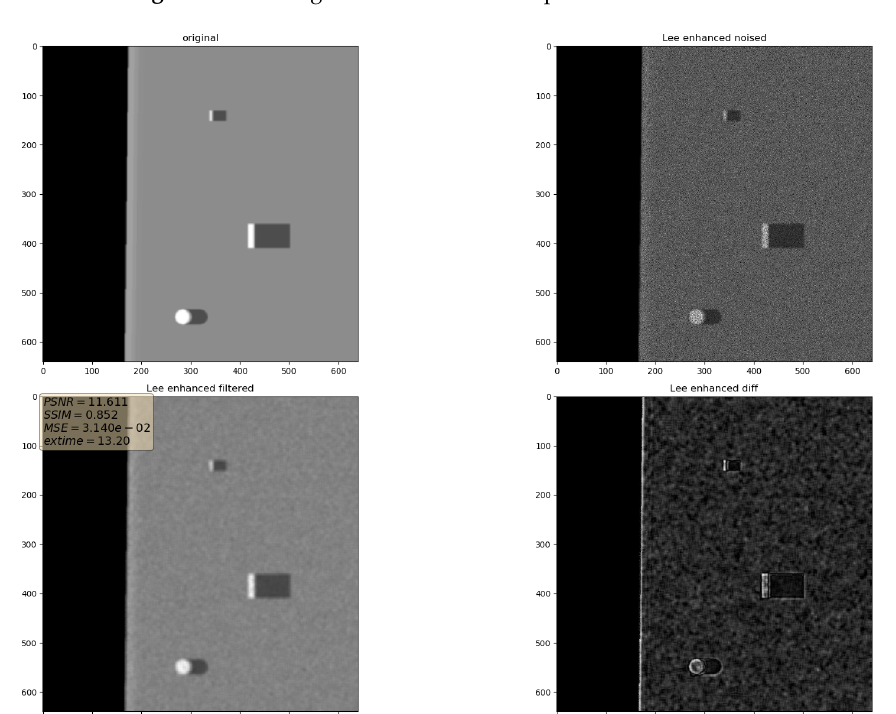
Figure 13. Filtering results for Lee enhanced filter. Speckle noise σ 2 =